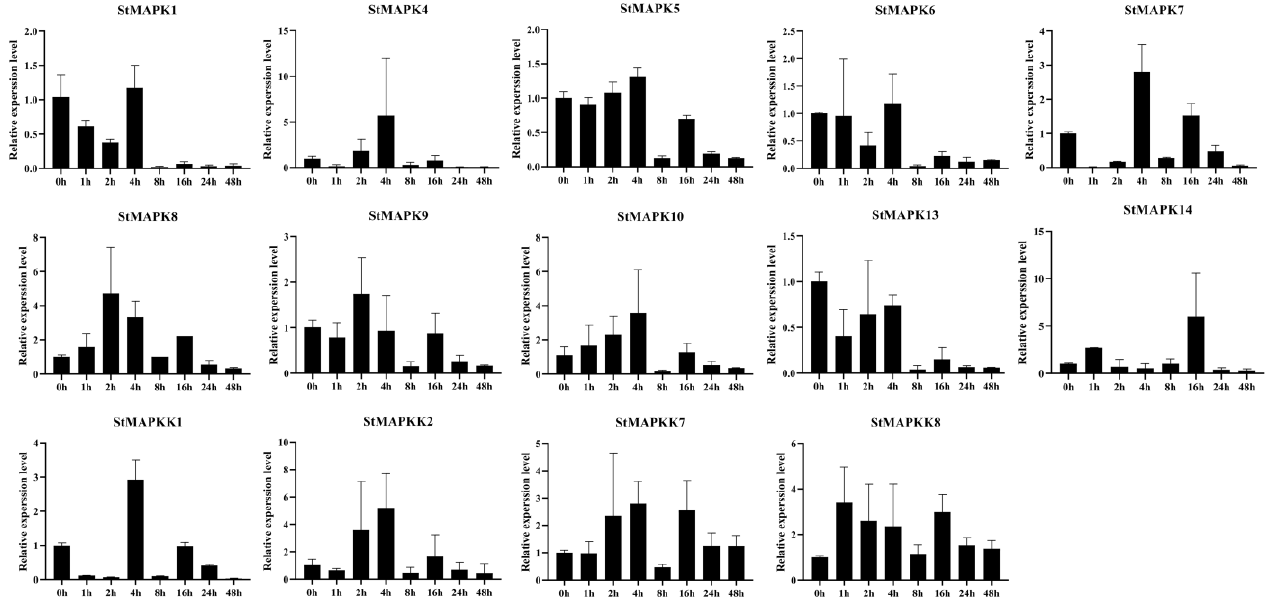
Figure 7. Expression pattern of StMAPK and StMAPK K after cold stress treatment at 2 °C.